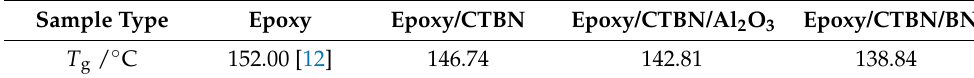
Table 1. Glass transition temperature of four kinds of samples.